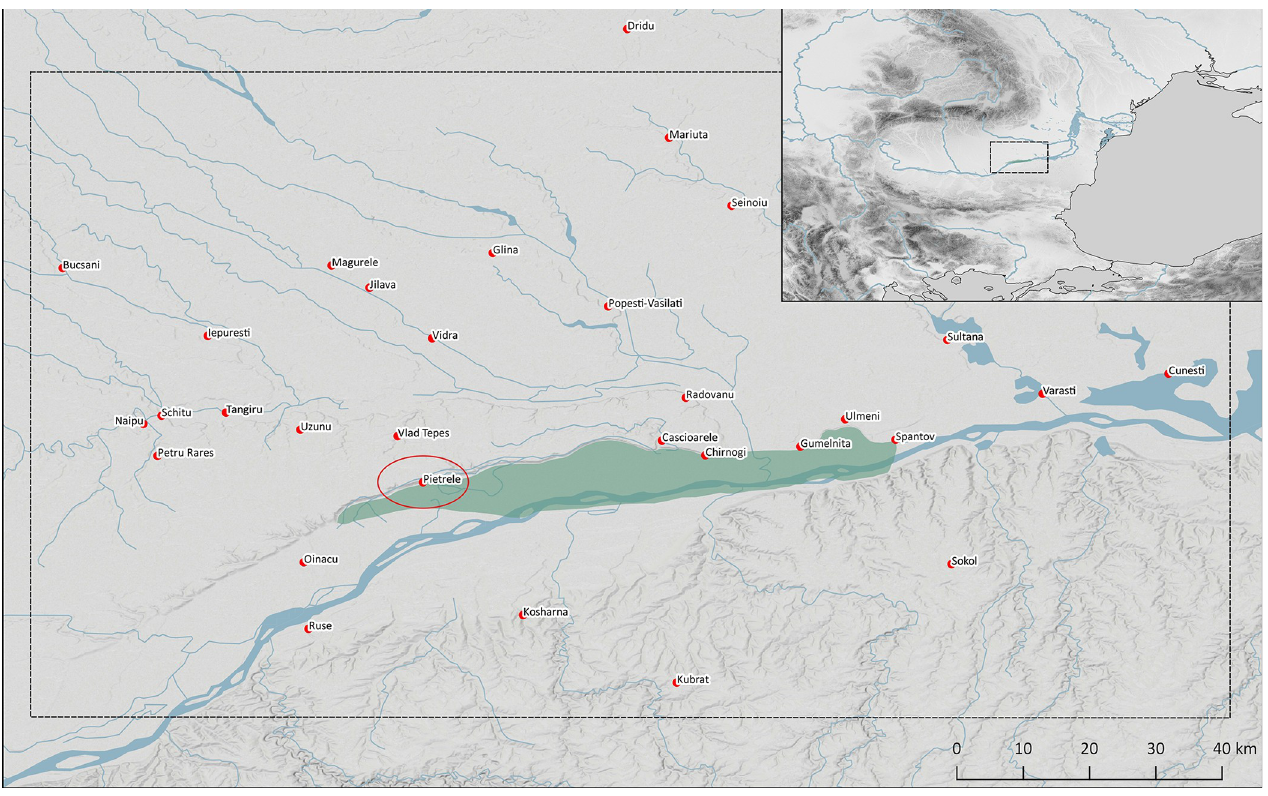
Fig 1. Map of Copper Age sites in the Lower Danube area and Bulgaria mentioned in the text (Map M. Karaucak).